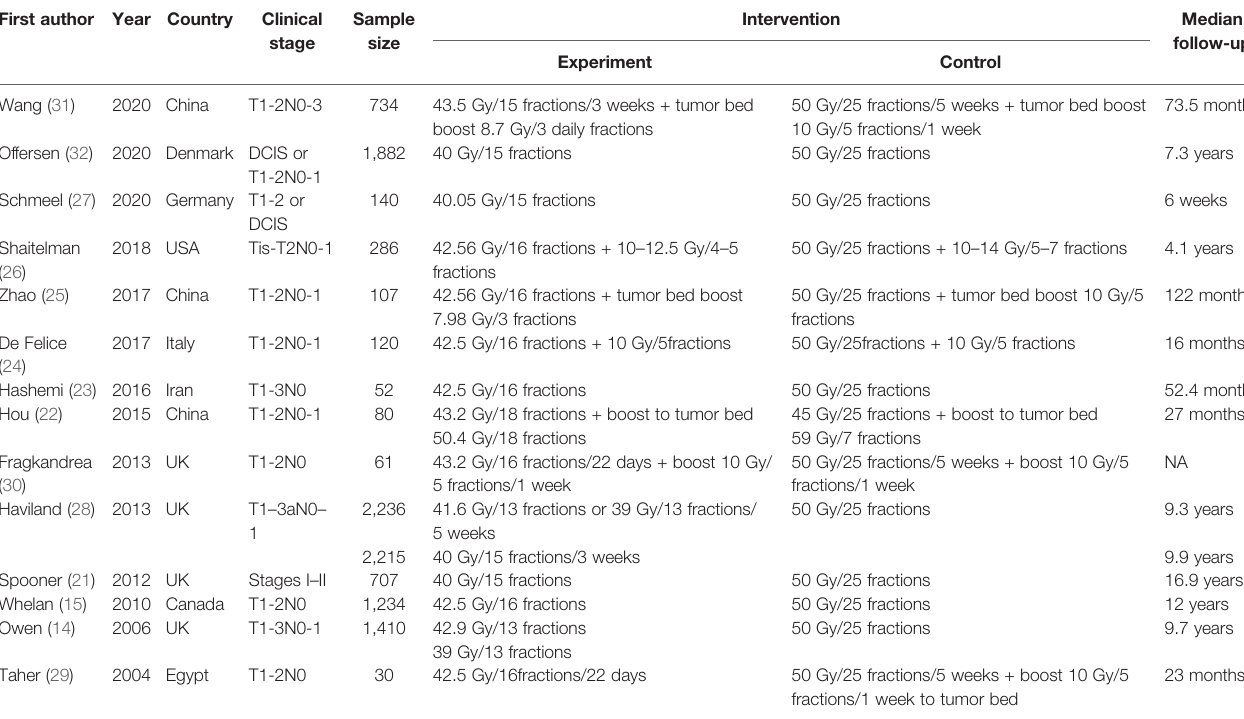
TABLE 1 | Characteristics of the included clinical trials in the